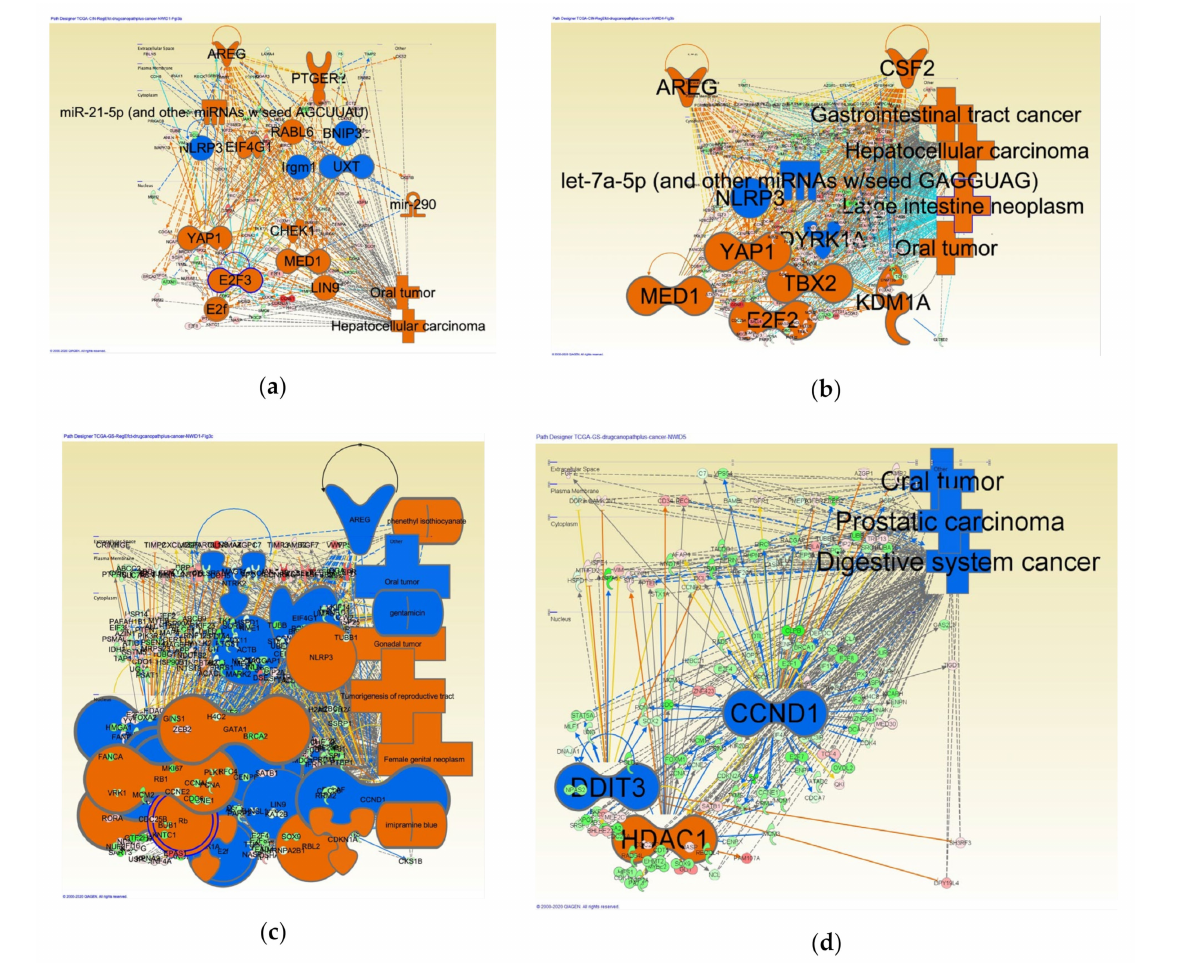
Figure 3. Networks for regulator e ff ects related to cancer in intestinal- and di ff use-type gastric cancer (GC). Regulator e ff ects were analyzed by IPA. The target disease was selected as cancer in the analysis. Typeofregulatorsanalyzedincludebiologicaldrug, canonicalpathway, andchemicaldrug.( a )Regulator e ff ect network ID1 (Hepatocellular carcinoma, Oral tumor) related to cancer in intestinal-type GC; ( b ) Regulator e ff ect network ID4 (Gastrointestinal tract cancer, Hepatocellular carcinoma, Large intestine neoplasm, Oral tumor) related to cancer in intestinal-type GC; ( c ) Regulator e ff ect network ID1 (Female genital neoplasm, Gonadal tumor, Oral tumor, Tumorigenesis of reproductive tract) related to cancer in di ff use-type GC; ( d ) Regulator e ff ect network ID5 (Digestive system cancer, Oral tumor, Prostatic carcinoma) related to cancer in di ff use-type